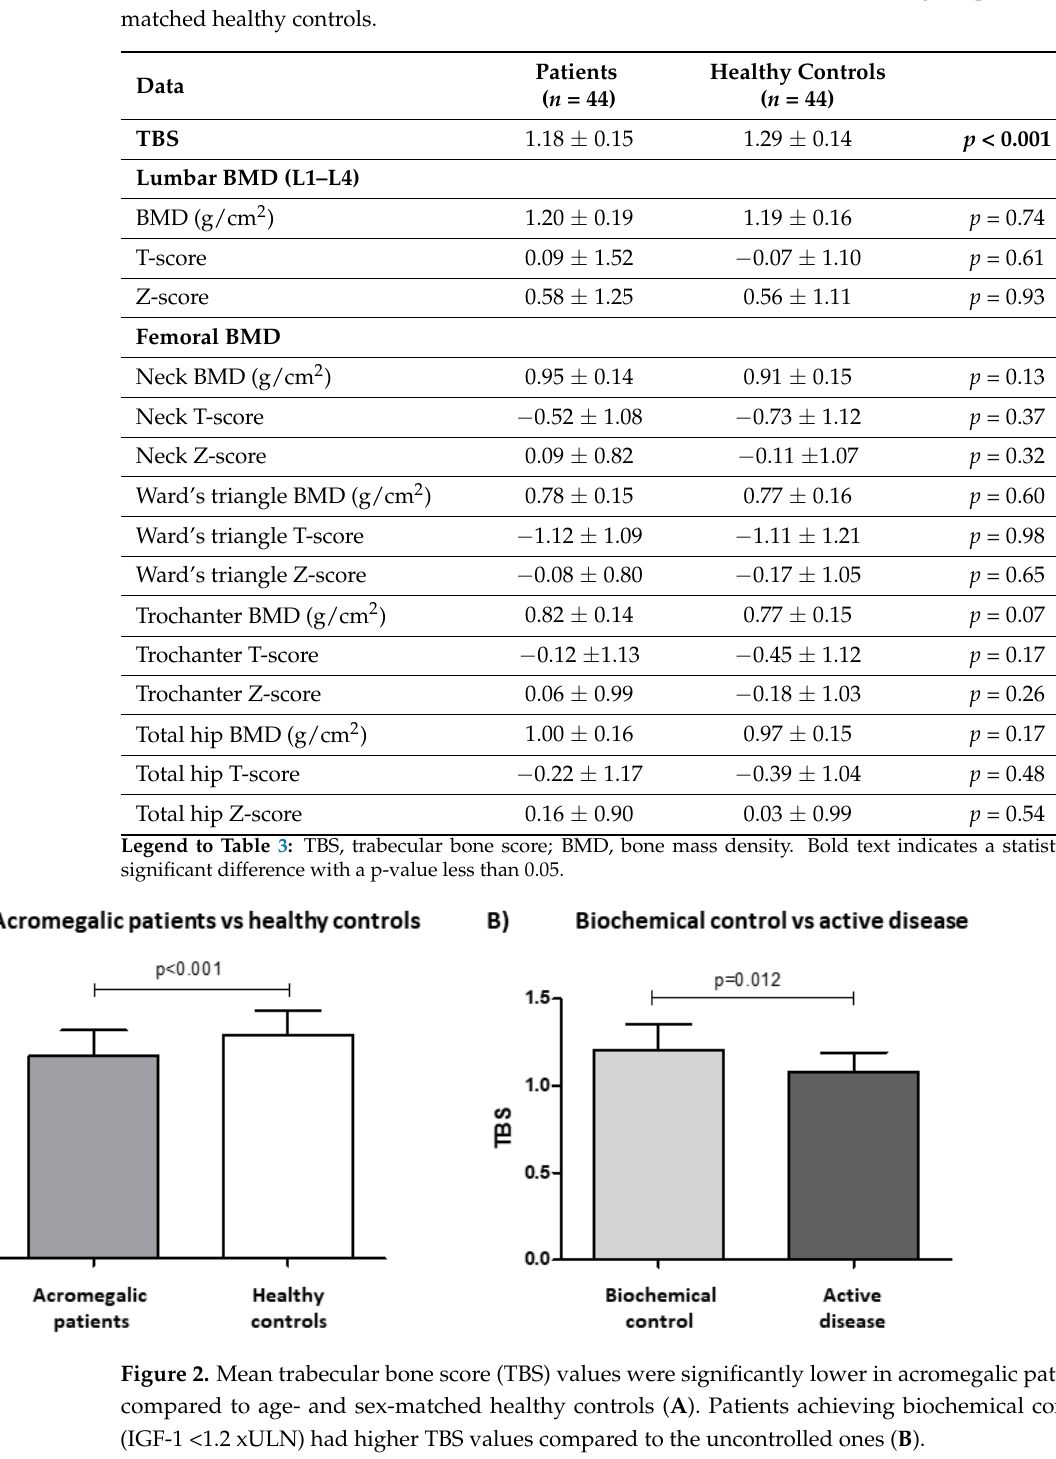
p = 0.54 Legend to Table 3: TBS, trabecular bone score; BMD, bone mass density. Bold text indicates a sta- tistically significant difference with a p-value less than 0.05. We observed a significant inverse correlation between TBS values and patients’ age ( r = −0 .44, p = 0.002), whereas sex, BMI, lifestyle, smoking habits, alcohol intake, familial history of osteoporosis, and time from diagnosis, did not significantly affect TBS. Interest- ingly, TBS in the control group was not significantly correlated with age ( r = −0 .22, p = 0.151), and, similarly to the observation in the patient group, sex and BMI did not affect TBS values, as well. Stratifying acromegalic patients based on IGF-1 levels, we found that controlled sub- jects (IGF-1 < 1.2 xULN) had higher TBS values compared to the uncontrolled ones (1.21 ± 0.15 vs 1.08 ± 0.12, p = 0.013). In this context, we observed a trend for an inverse correlation